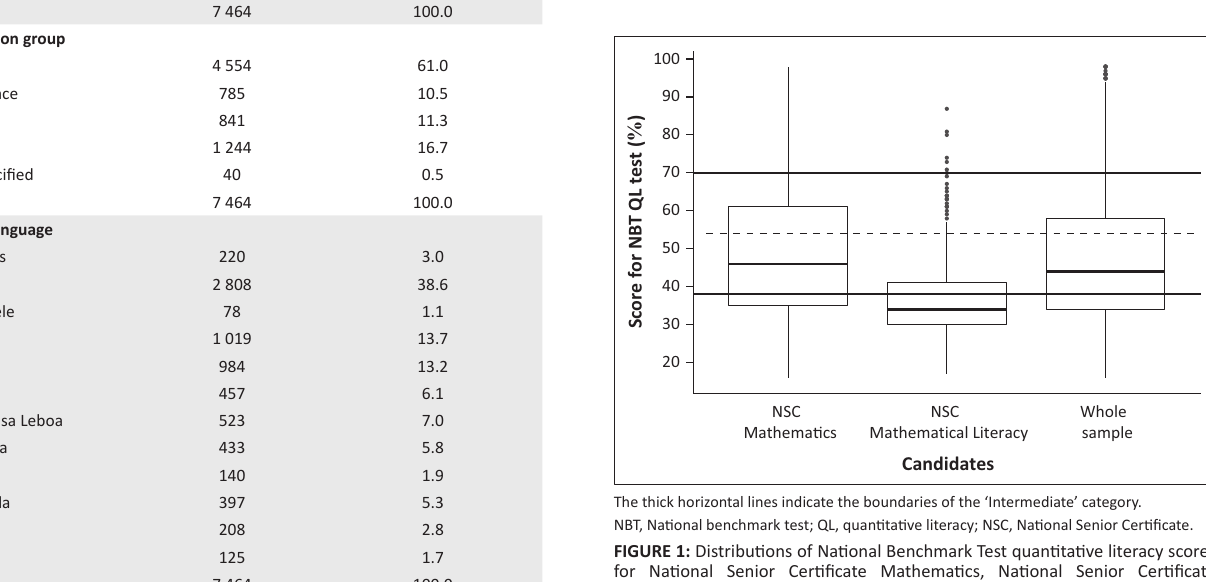
FIGURE 1: Distributions of National Benchmark Test quantitative literacy scores for National Senior Certificate Mathematics, National Senior Certificate Mathematical Literacy candidates and for the whole